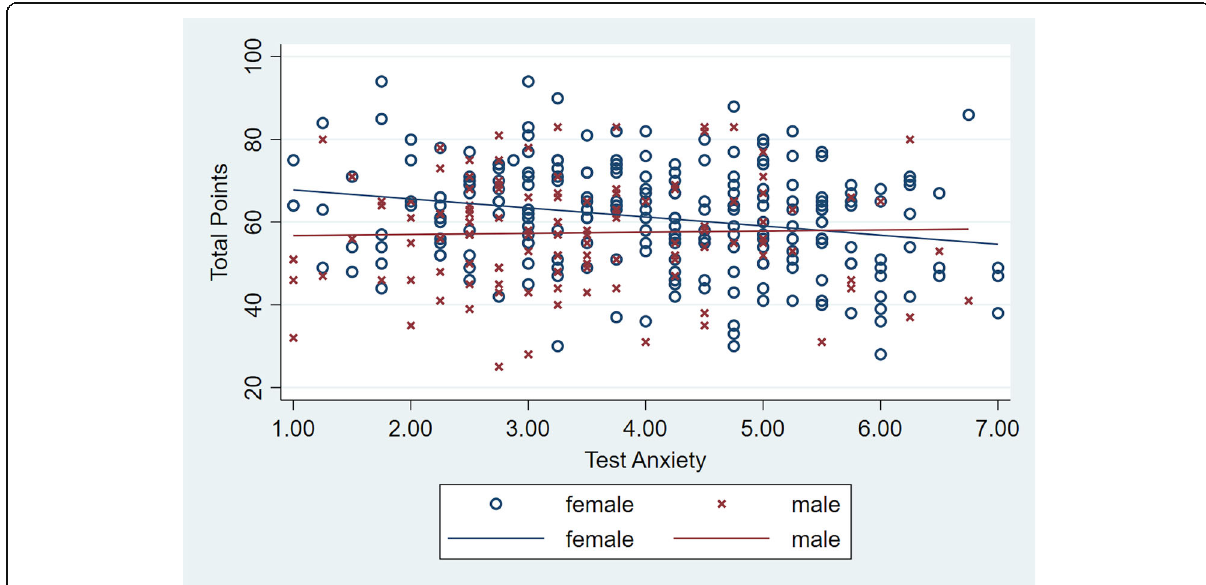
Fig. 1 Differential impact, by gender, of test anxiety on total points in the course. Note. For women, but not for men, test anxiety was a significant negative predictor of performance